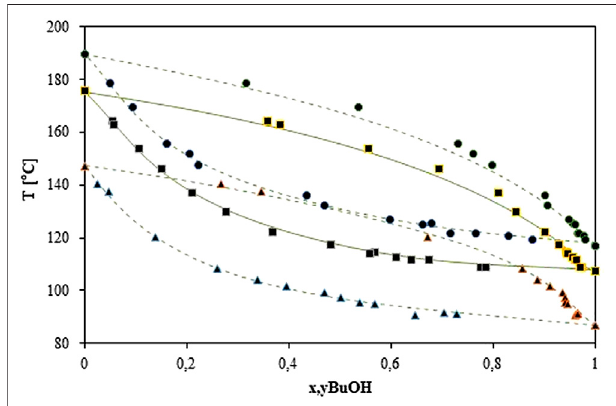
FIGURE 4 | T − x − y diagram for the system butanol – butyl glycolate measured experimentally at 300 mbar ( ▲ ), 700 mbar ( ■ ), and 1013.25 mbar ( C ); and calculated by NRTL adjusted